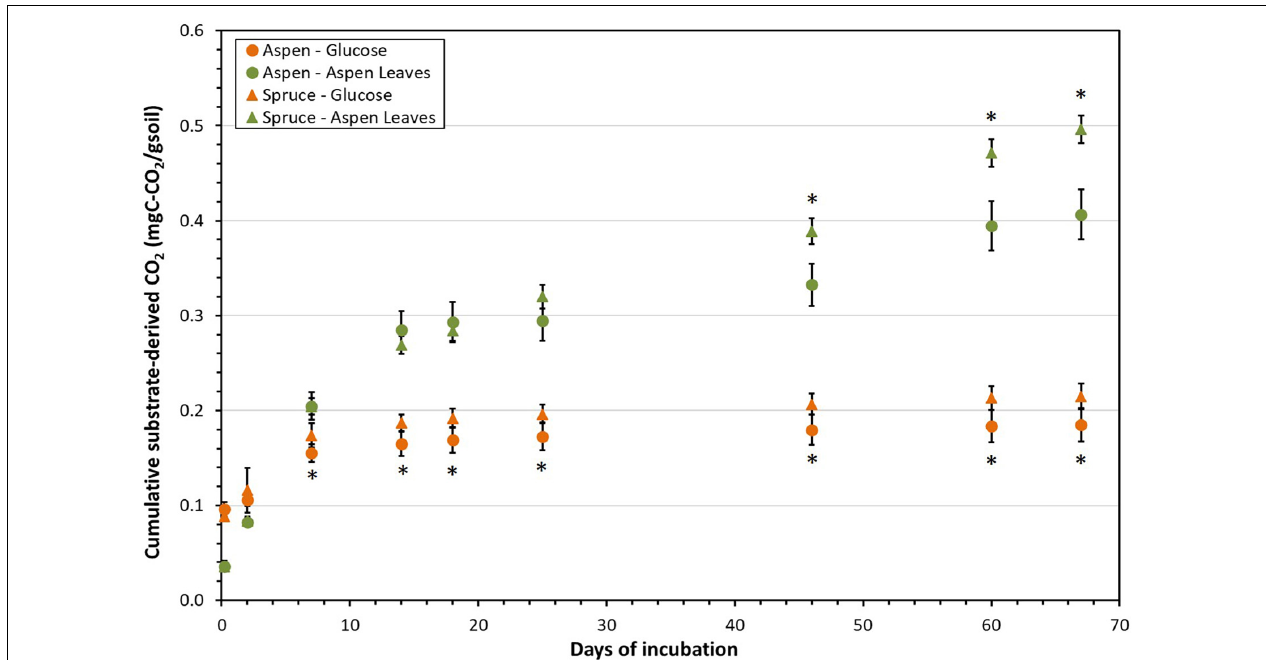
FIGURE 2 | Cumulative substrate-derived CO 2 fluxes (mgC-CO 2 /gsoil) from the aspen (circles) and spruce (triangles) soil incubation units following addition of glucose and aspen leaves during the 67-day laboratory incubation. Asterisks indicate dates where significant differences were detected between aspen and spruce ( p < 0.05). TABLE 2 | Priming effect (PE%), corresponding to % increase or decrease in soil C mineralized after 4 h and 2 days of incubation following addition of glucose, aspen leaves and aspen roots. Aspen forest floor Spruce forest floor Glucose Leaves Roots Glucose Leaves